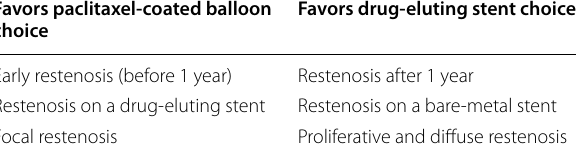
Table 4 Preferences for using paclitaxel-coated balloon